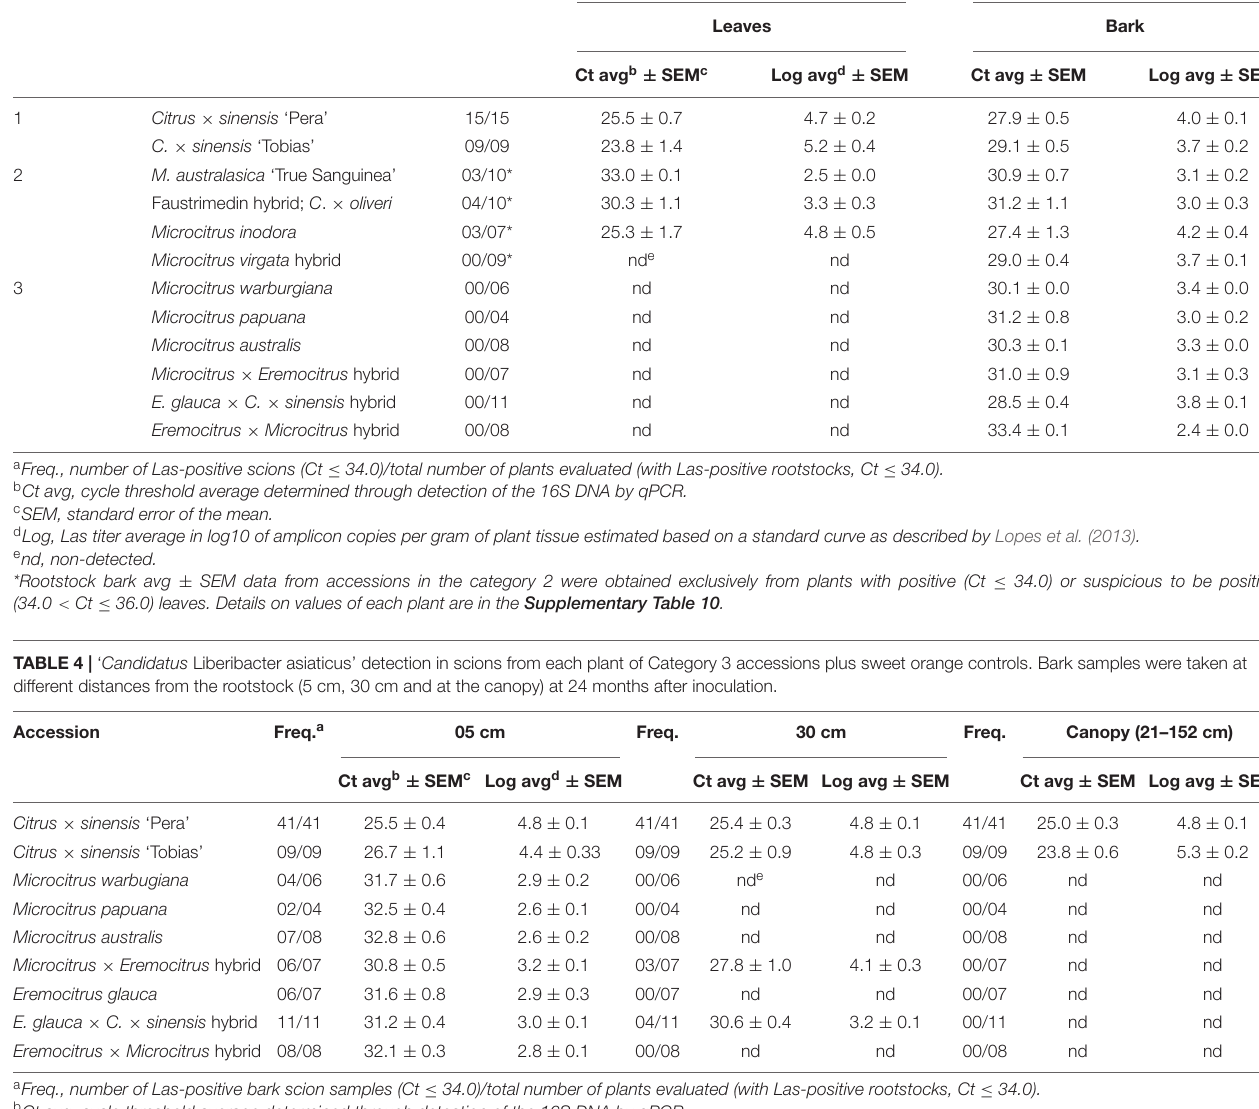
TABLE 3 | ‘Candidatus Liberibacter asiaticus’ infection in the Citrinae genotypes re-evaluated at 24 months after inoculation, as determined through detection of the 16S rDNA by qPCR. Category Freq. a Scion Rootstock